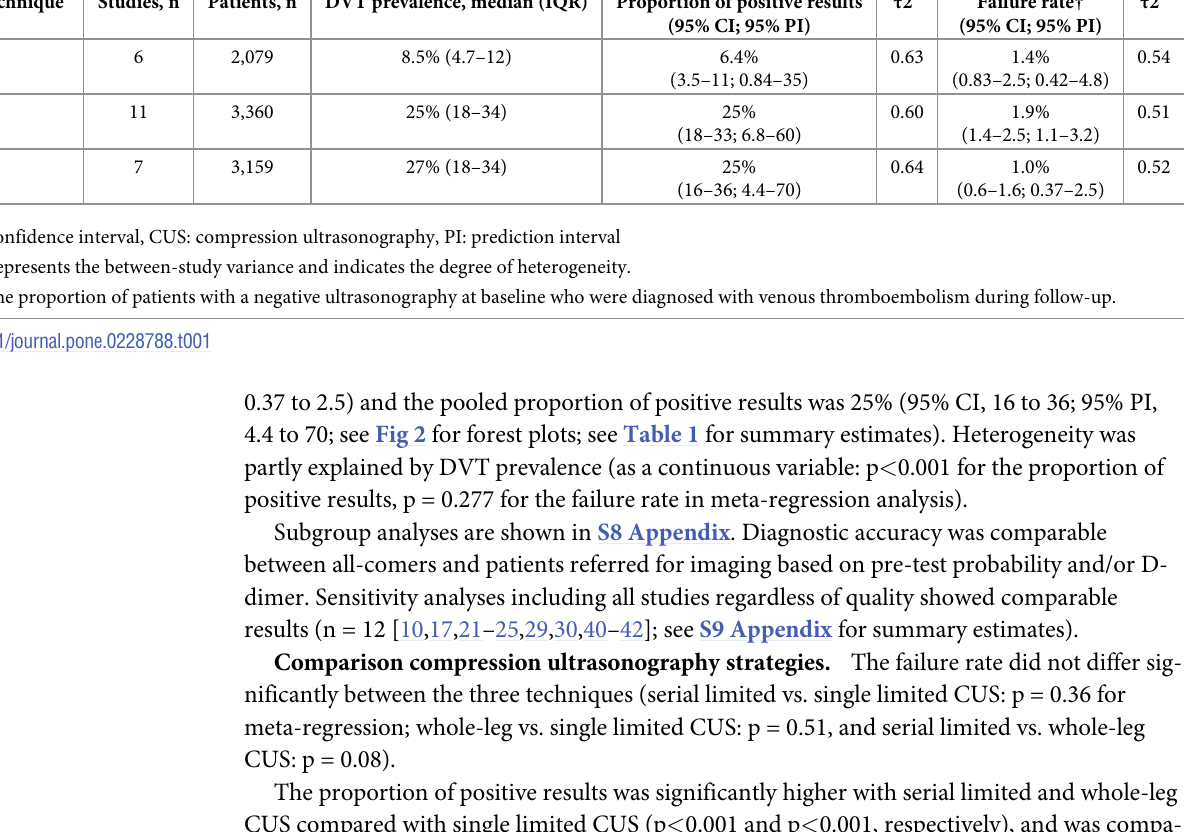
Table 1. Summary estimates diagnostic accuracy of compression ultrasonography in studies that used clinical follow-up as a reference standard. Ultrasonography technique